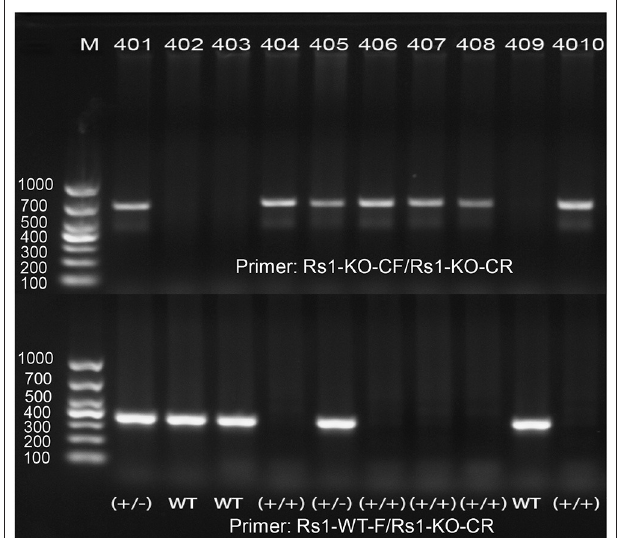
FIGURE 2 | PCR amplification demonstrates the correct targeting of Rs1 gene. One band of 350 bp was shown in WT, one band of 670 bp was shown in Rs1 − / Y mice, and both bands of 350 and 670 bp were shown in